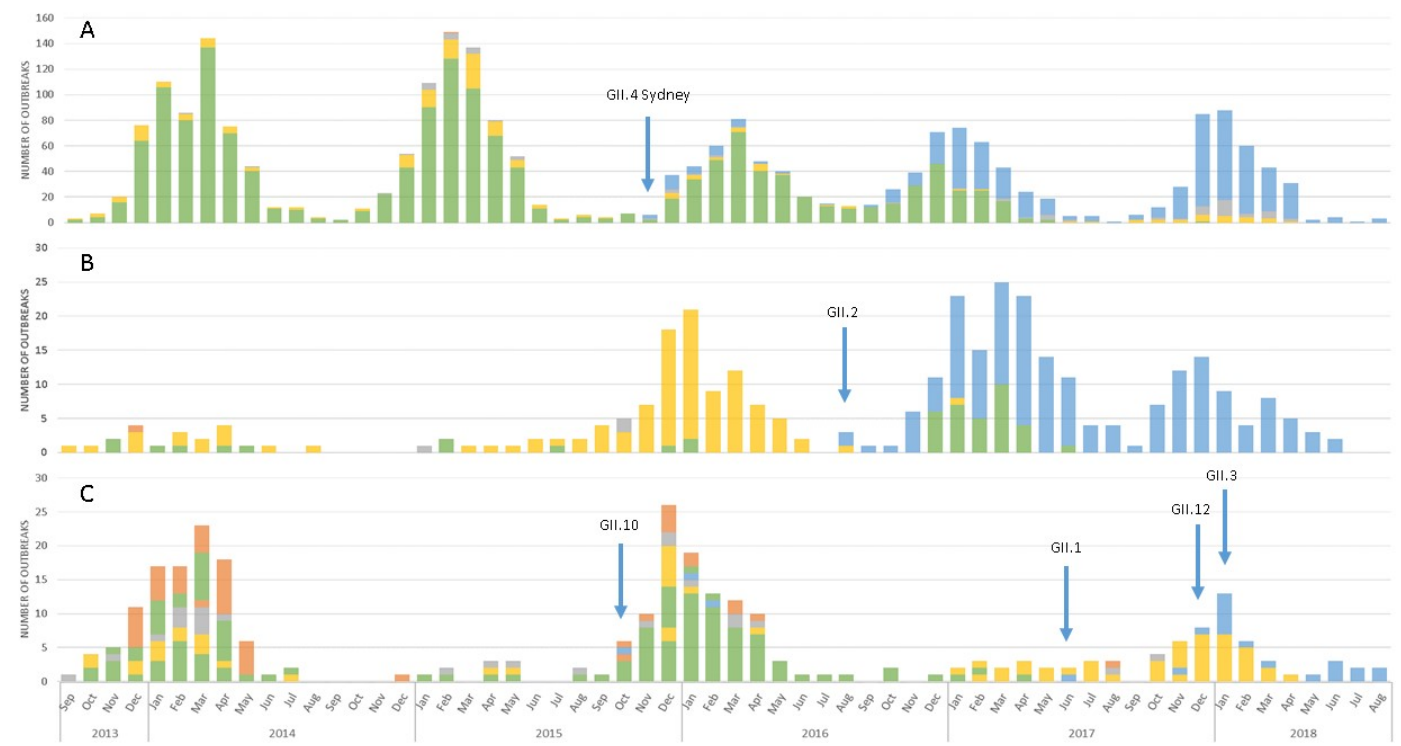
Figure 1. Outbreak distribution and emergence of a novel GII.P16 polymerase among ( A ) GII.4 Sydney ( n = 2355), ( B ) GII.2 ( n = 329) and ( C ) GII.1, GII.3, GII.10, GII.12, and GII.13* ( n = 291). Noroviruses containing a novel GII.P16 polymerase corresponding to GII.4 Sydney, GII.2, GII.10, GII.1, GII.12, and GII.3 are shown in blue. Other polymerase types associated with GII.4 Sydney include GII.Pe (yellow), GII.P4 (grey), extant GII.P16 (orange), and unknown polymerase types (green). Other polymerase types associated with GII.2 include GII.P2 (yellow), GII.Pe (grey), extant GII.P16 (orange), and unknown polymerase types (green). GII.Pg-GII.1, GII.P12-GII.3, GII.Pc-GII.10, and GII.Pg-GII.12 viruses (yellow), GII.P21-GII.3, GII.Pg-GII.10, GII.Pq-GII.13 viruses (grey), GII.P16-GII.3 and GII.P16-GII.13 (extant) viruses (orange), and unknown polymerase types associated with GII.1, GII.3, and GII.13 capsids (green). The blue arrows indicate month and year of first report of novel GII.P16 polymerase associated with noted capsid. *GII.13 is only associated with extant GII.P16 and is included in the figure due to its association with GII.P16.